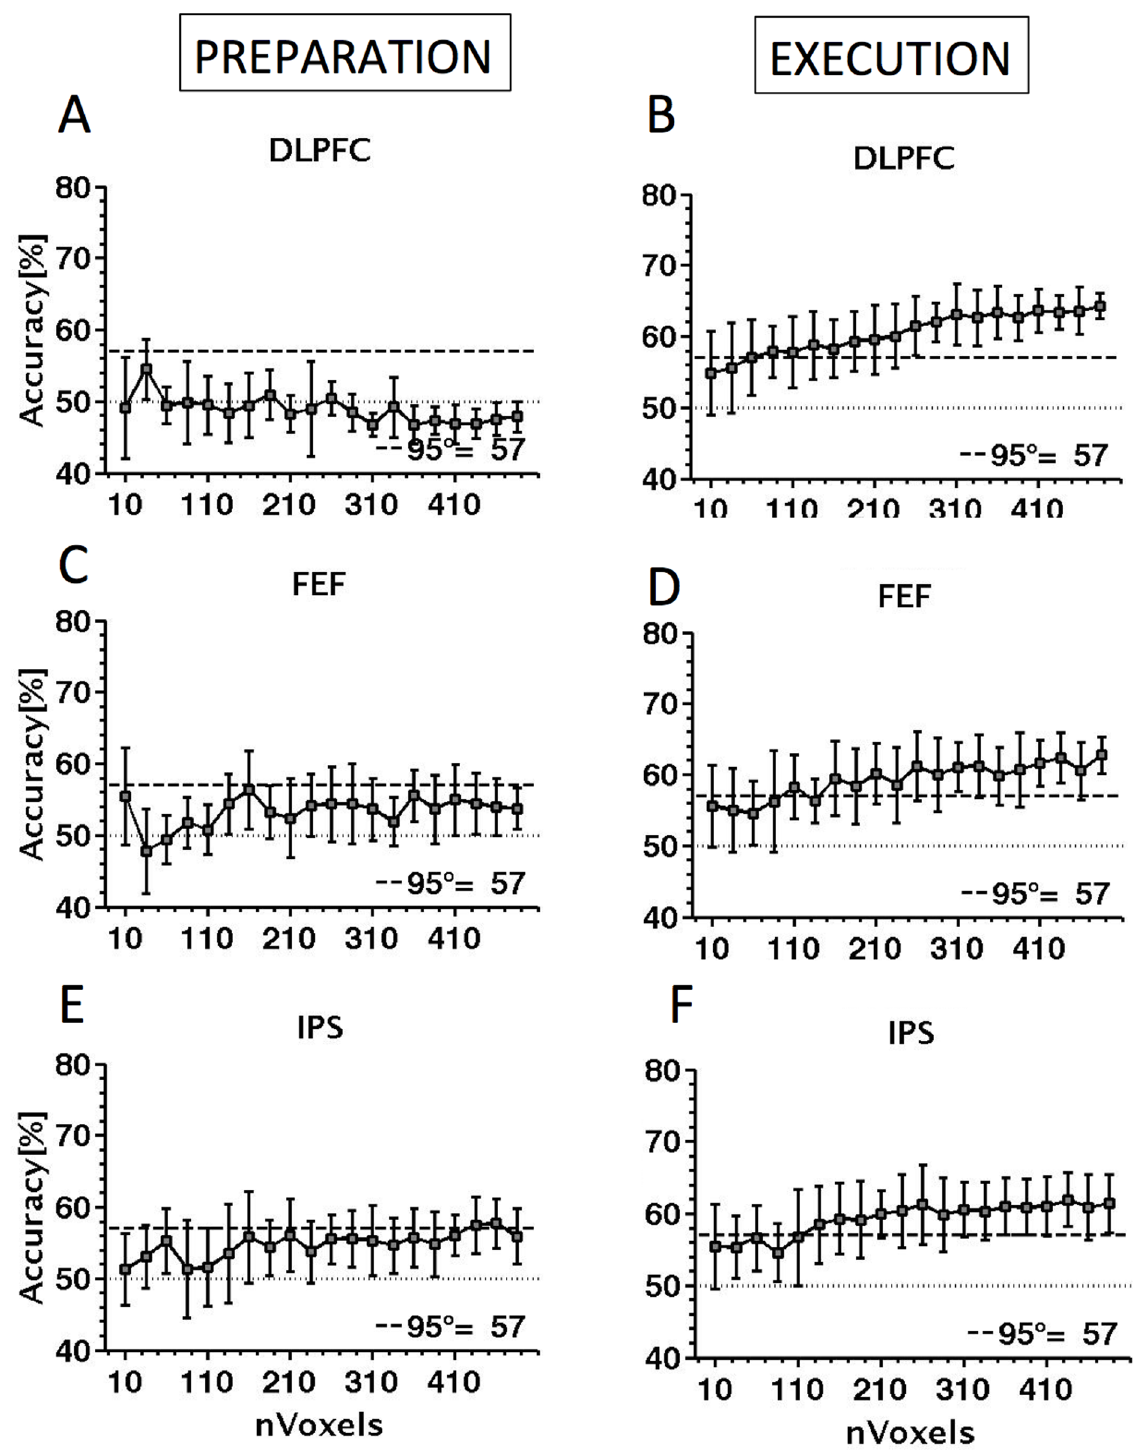
Fig 5. Decoding performance for saccade type (pro-saccade vs. anti-saccade) for the three cortical regions examined. In each plot, performance is shown as a function of voxel sample size (number of exemplars) included in the MVPA analysis. Decoding performance is shown separately for the preparation phase (A, C, E) and the execution phase (B, D, F), for the DLPFC (A, B), the FEF (C, D) and the IPS (E, F). Each point is the mean performance from 20 random voxel selections of the size shown on the abscissa. Also shown are the chance decoding performance (dotted line) and the performance level that is significantly above chance at p < 0.05 derived by permutation testing (dashed line).